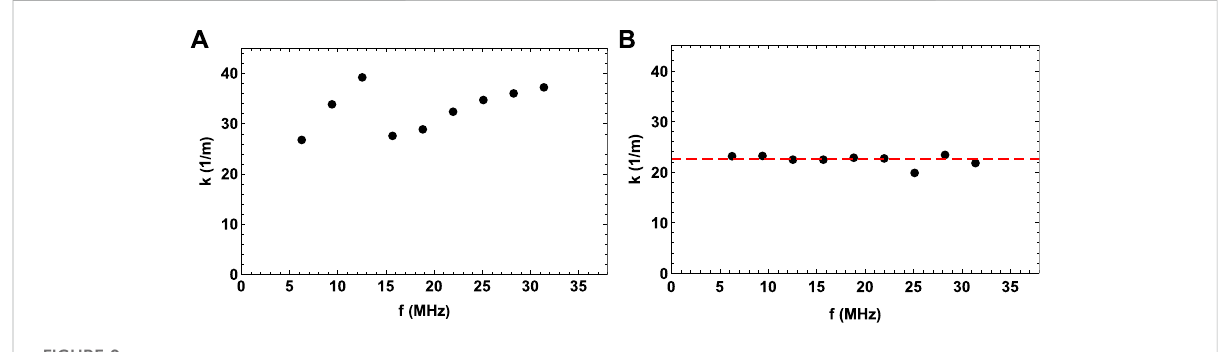
FIGURE 9 Dispersion relations inside (A) , ( r = 0 m) and outside (B) , ( r = 0.04 m) the blue-core column for B 0 = 0.16 T.